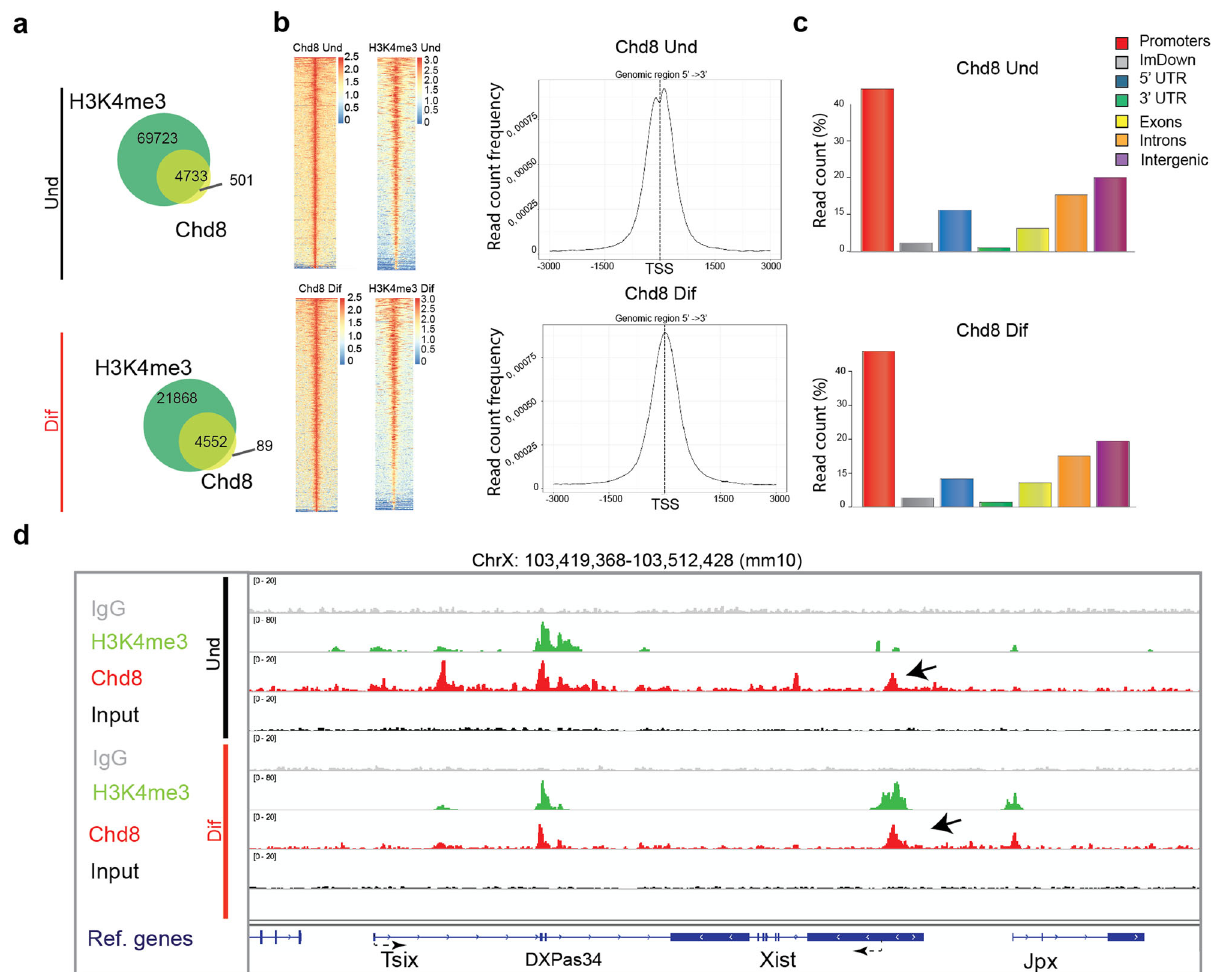
Fig. 1 Characterization of the genomic distribution of Chd8 and H3K4me3 peaks. a Overlap between Chd8 and H3K4me3 peaks; top undifferentiated (Und) and bottom differentiated conditions (Dif) from two biological experiments. b Heatmaps showing the distribution of Chd8 and H3K4me3 peaks in the genome (left). Association of Chd8 peaks with transcriptional start sites (TSS); top undifferentiated, bottom differentiated conditions (right). Data from two biological replicas is shown. c Genomic features distribution of Chd8 consensus peak sets; top undifferentiated, bottom differentiated conditions. Selected-features are shown (e.g. Promoters, Immediate downstream region (ImDown), etc.). Data from two biological experiments is shown. d Chd8 distribution at aligned sequence reads at the Xist and Tsix promoter regions. Black arrows indicate Chd8 peaks at the Xist promoter. A single representative set of ChIP-seq pro fi les is shown. Red: Chd8, green: H3K4me3, grey: IgG, black: input. Samples and antibodies used are indicated in the fi